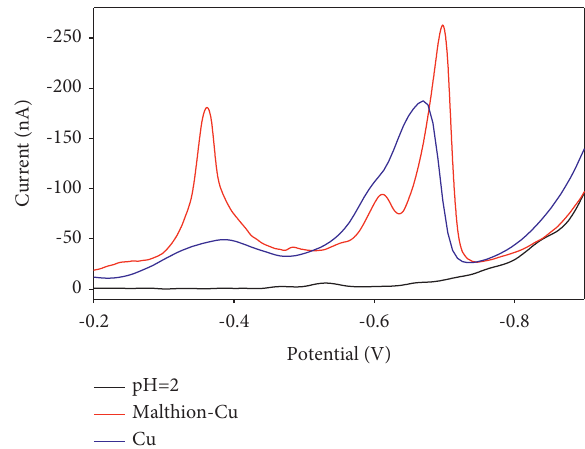
Figure 2: SW-CSVs of the supporting electrolyte at pH 2 (black line), in the presence of Cu 2+ ions (green line), and in the presence of malathion and Cu 2+ ions (red line). Conditions: [Malathion] � 6 × 10 − 8 M, [copper (II)] � 3.4 × 10 − 7 M, E acc � –0.2V; t acc � 120 s; sweep rate � 0.1 V/s, pulse amplitude of 50mV, and frequency 60Hz.